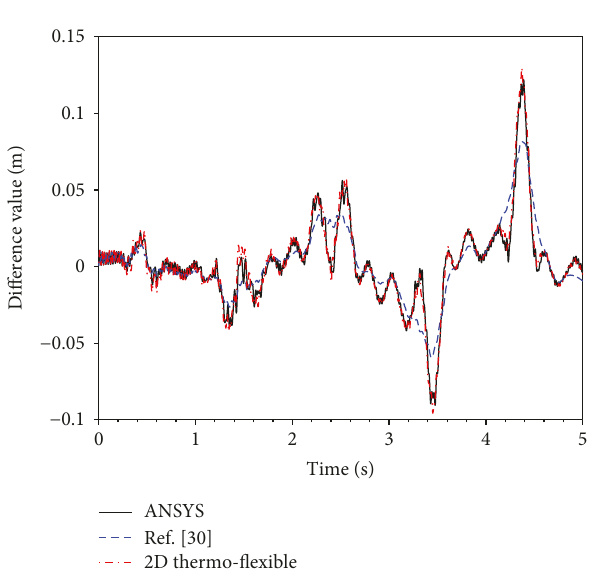
Figure 4: Di ff erence value.